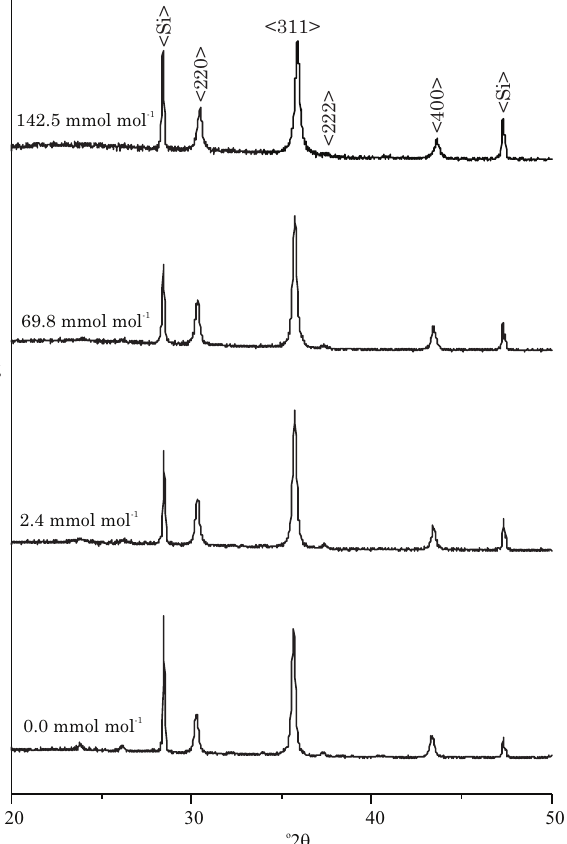
Figure 1. X-ray diffraction patterns for the Al- substituted maghemites. Si: silicon as internal standard.